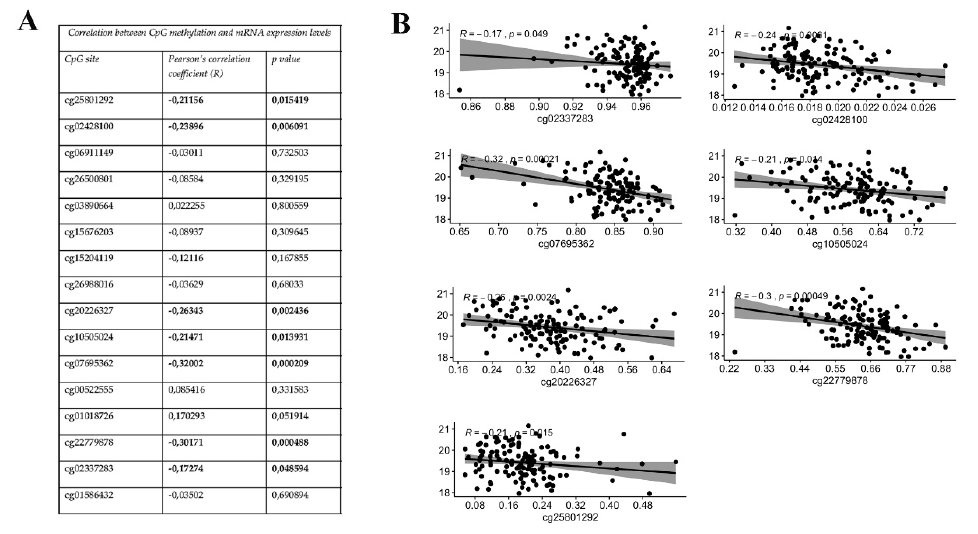
Figure 5. ( A ) Results from correlation analysis between KEAP1 methylation (450 K BeadChip array, Beta-values) and its expression levels (RNA-Seq, TPM-normalized read counts). ( B ) Scatter plots between β -values (x-axis) and expression values of KEAP1 in the TCGA LUSC non-metastatic disease dataset include the most significantly correlated CpG sites. Pearson’s correlation coefficient ( R ) and significance level ( p ) are also reported for each plot.